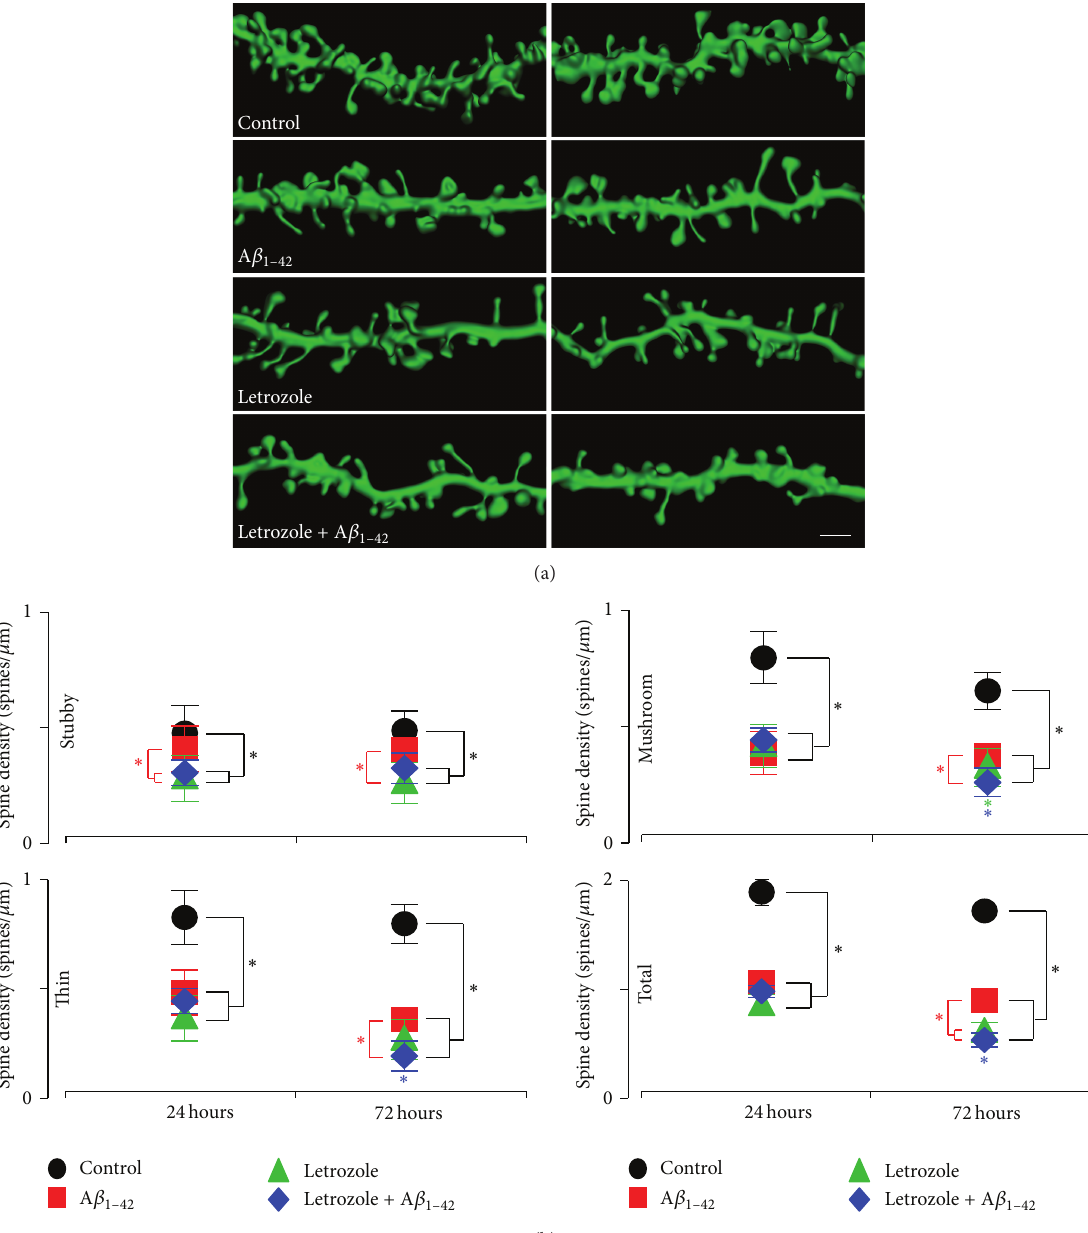
Figure 4: Letrozole and 𝐴𝛽 1 reduce the number of dendritic spines. (a) Representative 3D reconstructions of dendritic segments from – 42 (1 𝜇 M), and letrozole (1 𝜇 M) or 𝐴𝛽 1 + letrozole (1 𝜇 M) for 24 or 72 hours. Scale sister cultures that were treated with either control, 𝐴𝛽 1 – 42 – 42 bar, 2 𝜇 m. (b) Quantification of the spine subtype densities following treatments. There is a significant decrease in the total dendritic spine , letrozole, and 𝐴𝛽 1 + letrozole-treated cultures compared to control after 24 hours. When spine subtypes are examined, densities for 𝐴𝛽 1 – 42 – 42 there are significant differences between control and treated cultures in mushroom and thin-type spines while spine density for stubby spines + letrozole compared to control and between 𝐴𝛽 1 and letrozole. Control, n = is only significantly different between letrozole and 𝐴𝛽 1 – 42 – 42 , 𝑛 = 428 𝜇 m of dendrite from 11 cells in 4 cultures; letrozole, total dendritic segment lengths of 441 𝜇 m from 10 cells in 4 cultures; 𝐴𝛽 1 – 42 𝑛 = 431 𝜇 m of dendrite from 10 cells in 4 cultures. There is a significant 𝑛 = 433 𝜇 m of dendrite from 9 cells in 4 cultures; 𝐴𝛽 1 – 42 + letrozole, decrease in the total dendritic spine densities compared to control cultures after 72 hours as well. In total spine density, cultures treated + letrozole had lower spine counts compared to cultures treated with 𝐴𝛽 1 alone. For mushroom and thin- with either letrozole or 𝐴𝛽 1 – 42 – 42 and letrozole had significantly lower spine densities compared to 𝐴𝛽 1 alone while stubby type spines, cultures treated with both 𝐴𝛽 1 – 42 – 42 alone. Control, 𝑛 = 500 𝜇 m of dendrite from 12 cells in 4 cultures; 𝐴𝛽 1 , spine density was lower for letrozole-treated compared to 𝐴𝛽 1 – 42 – 42 𝑛 = 441 𝜇 m 𝑛 = 465 𝜇 m of dendrite from 10 cells in 4 cultures; letrozole, 𝑛 = 489 𝜇 m of dendrite from 11 cells in 4 cultures; 𝐴𝛽 1 – 42 + letrozole, + letrozole had significant decrease in total spine densities between of dendrite from 9 cells in 4 cultures. Only cultures treated with 𝐴𝛽 1 – 42 24 and 72 hours of treatment. This difference is contributed by significant decrease in spine density in both mushroom and thin type